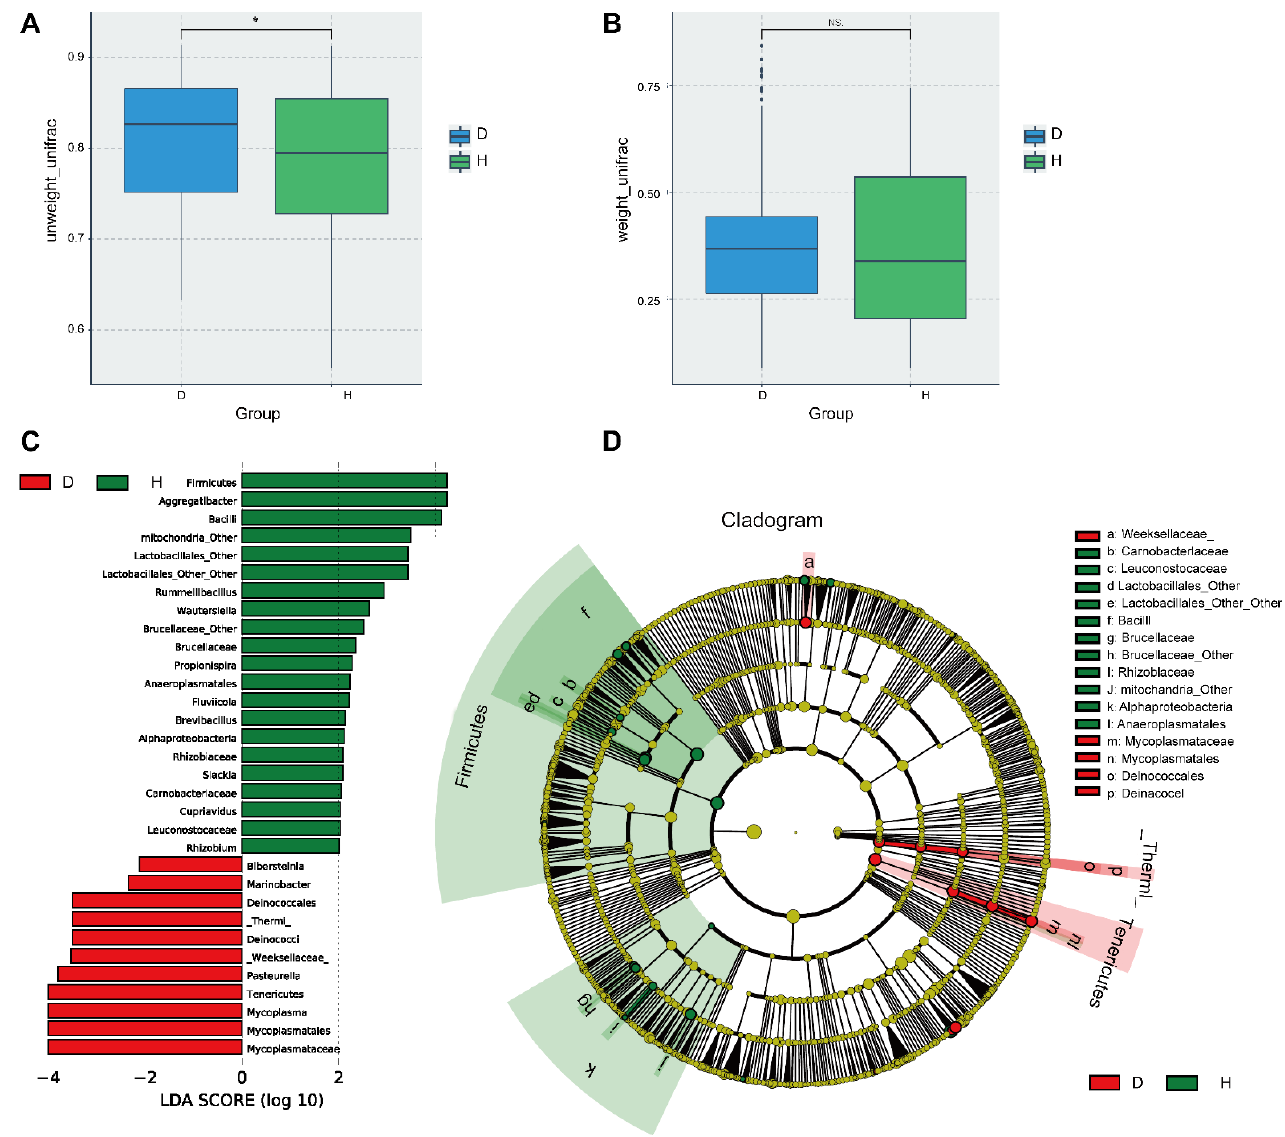
Figure 3. Beta-diversity and LEfSE analysis. Boxplots of the beta-diversity of nasal microbiota comparing the diseased (D) group and the healthy (H) group. The comparison between groups were performed by T-test. * p < 0.05, significant, NS, not significant. ( A ) Unweighted-UniFrac. ( B ) Weighted-UniFrac. ( C ) The LDA score was computed from differences in feature abundance between the D and H groups. Features were selected according to logLDA score > 3.6. ( D ) Taxonomic cladogram from LEfSe, depicting the taxonomic association between microbial communities from the D and H groups. Each node represents a specific taxonomic type. Yellow nodes denote taxonomic features that are not significantly different between the D and H groups. Red nodes denote the taxonomic types with greater abundance in the D group, while green nodes represent the taxonomic types that are more abundant in the H group. D: bovines with respiratory disease, H: healthy